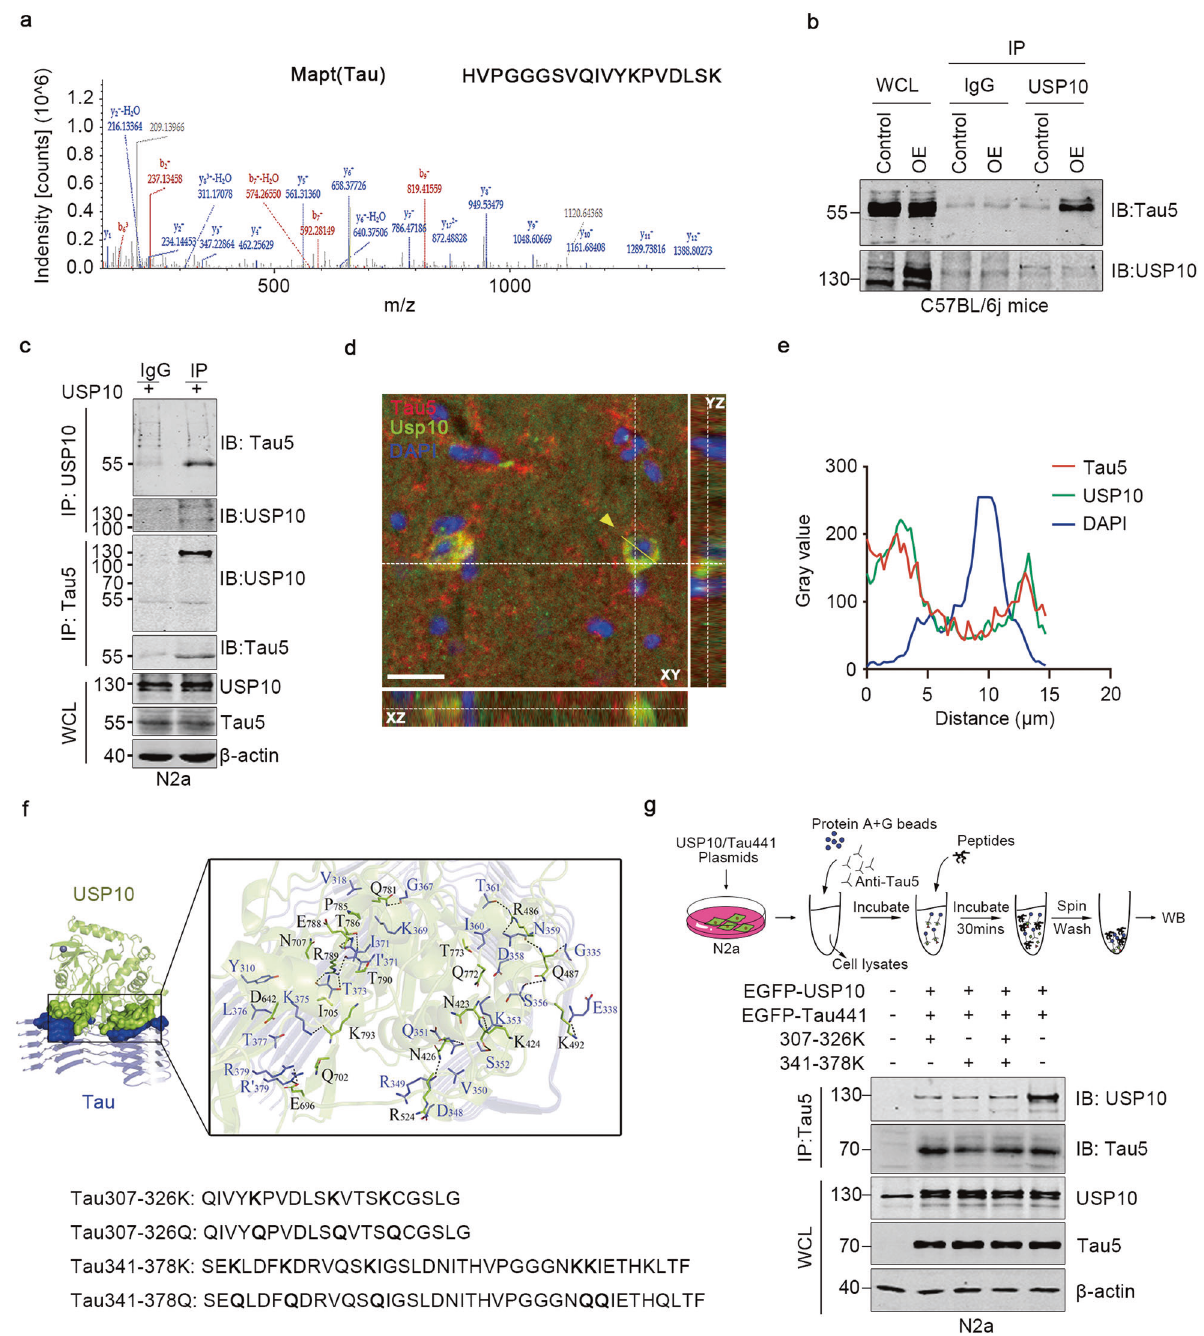
Fig. 5 Synthesized peptides block USP10 interaction with Tau. a Mass spectrometry analysis of USP10-interacting proteins. The detected Mapt (Tau) typical mass spectrometry peptide spectra were listed. The list of USP10-interacting proteins is provided in Supplementary Table S3. b USP10 interacts with Tau5 in C57BL/6j mice tissue. AAV9-USP10 was injected into the hippocampus of wild-type C57BL/6j mice, tissues were immunoprecipitated with USP10 and subjected to western blotting. c USP10 interacts with Tau5 in N2a cells. Immunoblots of co- immunoprecipitation (upper) or reverse co-immunoprecipitation (lower) of USP10 and Tau5. WCL were analyzed using western blotting. d Confocal microscopy Z-stack imaging to hippocampus region of 13-month-old APP/PS1 mice. Immunostaining of Tau5 (Red), USP10 (Green), and DAPI (blue). X – Z, X-Y and Y-Z directions were shown. Yellow dotted lines represent the Z-depth of the 5 µm optical slice, and the yellow line represents the statistical area. The scale bar is 20 μ m. e Statistical analysis of USP10, Tau5, and DAPI immunoreactivity. f Visualization of molecular docking of USP10 and Tau5 of the lowest energy, and the design of a series of blocking peptides targeting the USP10-Tau interaction interface. g Upper panel was a schematic of experimental process. N2a cells were co-transfected with USP10 and Tau. Cytoplasmic extracts were immunoprecipitated with a Tau5 antibody. The peptides Tau 307-326 K, Tau341-378K, or Tau 307-326 K + Tau341-378K at a concentration of 1 mM for 30 min at room temperature were used to compete with the USP10-Tau interaction in vitro. IP and WCL samples were blotted with the indicated